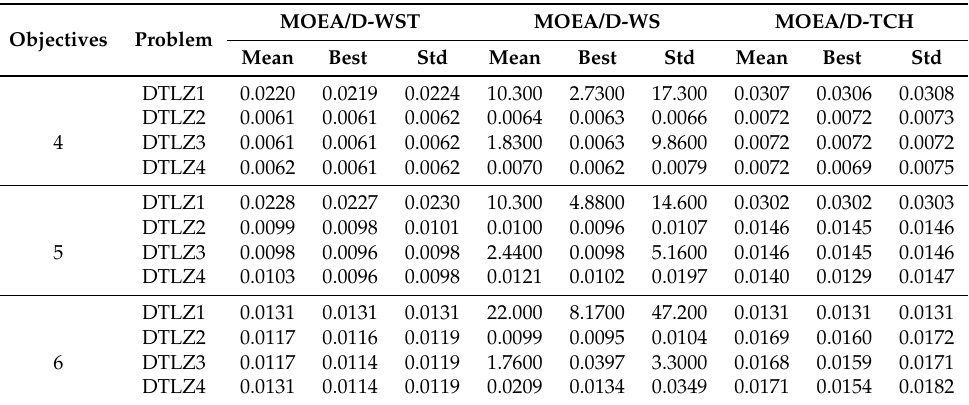
Table 3. Statistics of the GD metric obtained by MOEA/D-WST, MOEA/D-WS and MOEA/D-TCH on